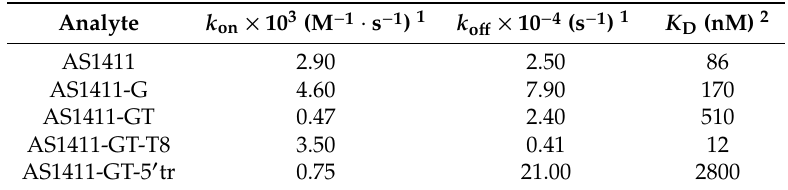
Table 3. Kinetic parameters and dissociation constants for the interaction of GROs with nucleolin determined by